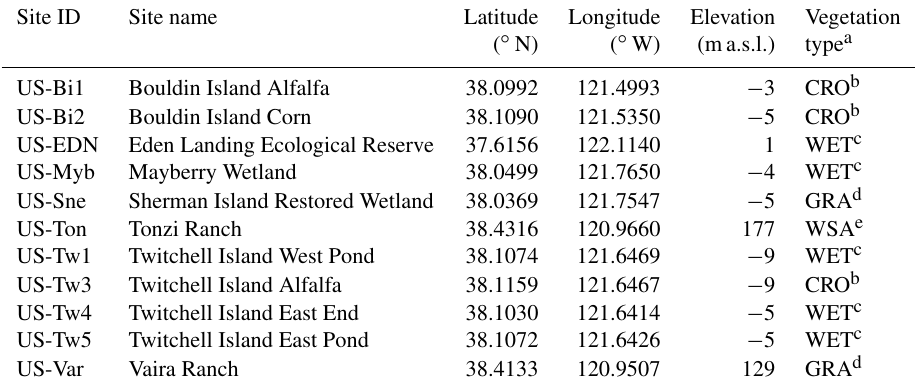
Table 1. AmeriFlux sites used in this study. Site ID Site